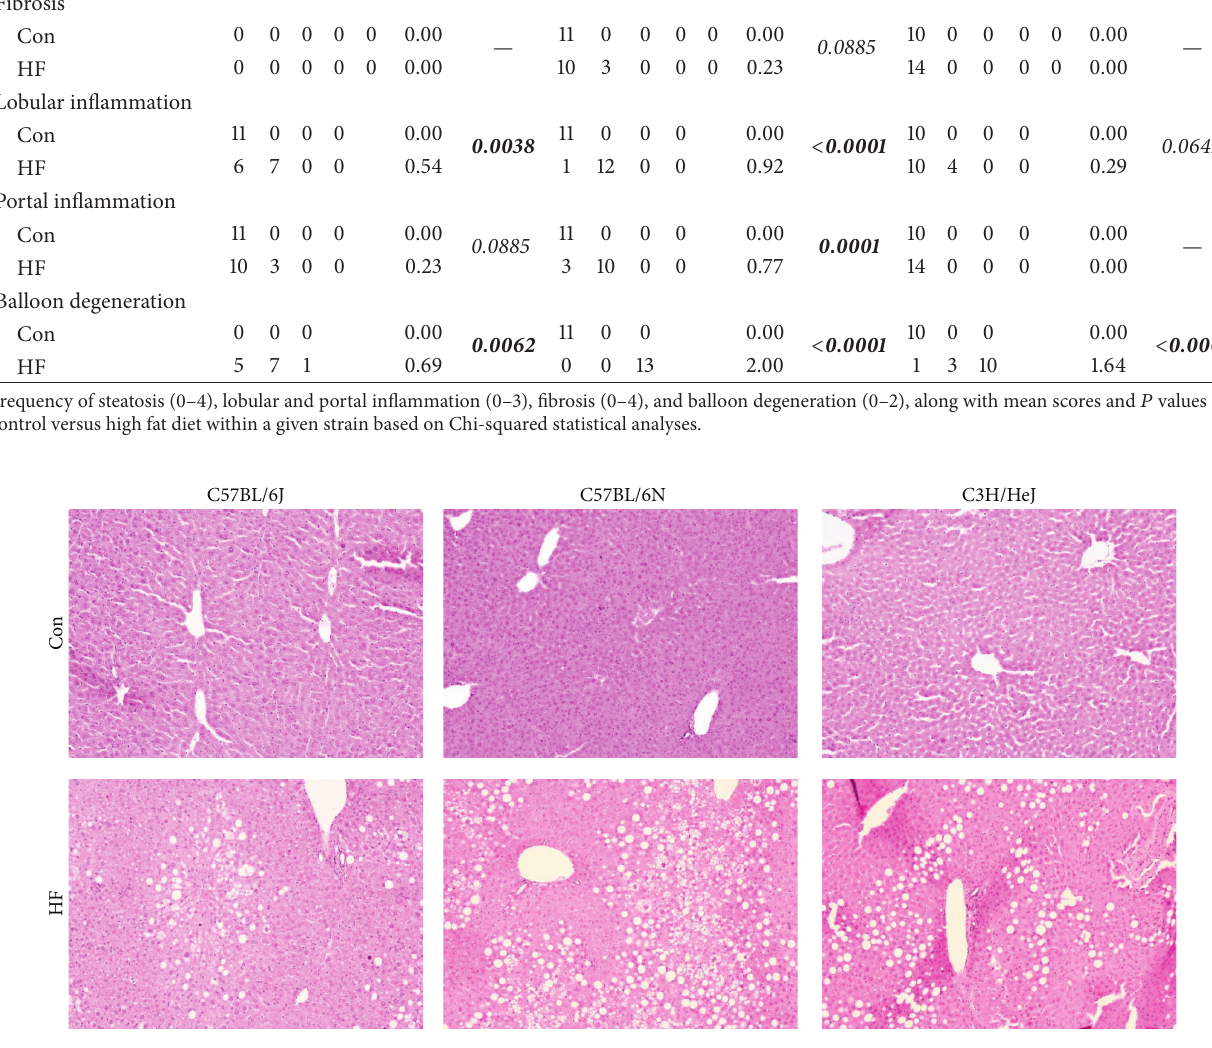
Figure 5: Representative micrographs of liver histology sections stained with hematoxylin and eosin from C57BL/6J, C57BL/6N, and C3H/HeJ mice following 24 wk on a control (Con; AIN-93M) or a high fat diet (HF; 45% kcal from fat). Representative images were photographed and are presented at a 10x